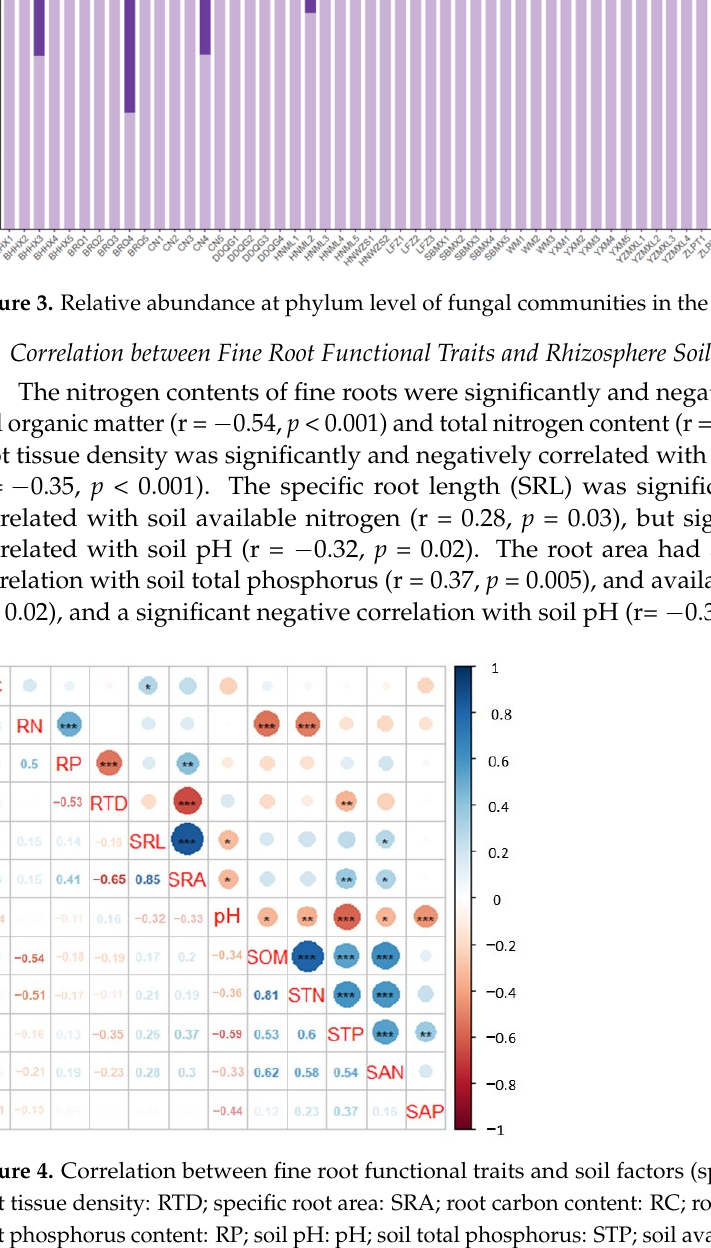
Figure 2. Relative abundance of the first 20 phylum levels of bacterial communities in the samples.